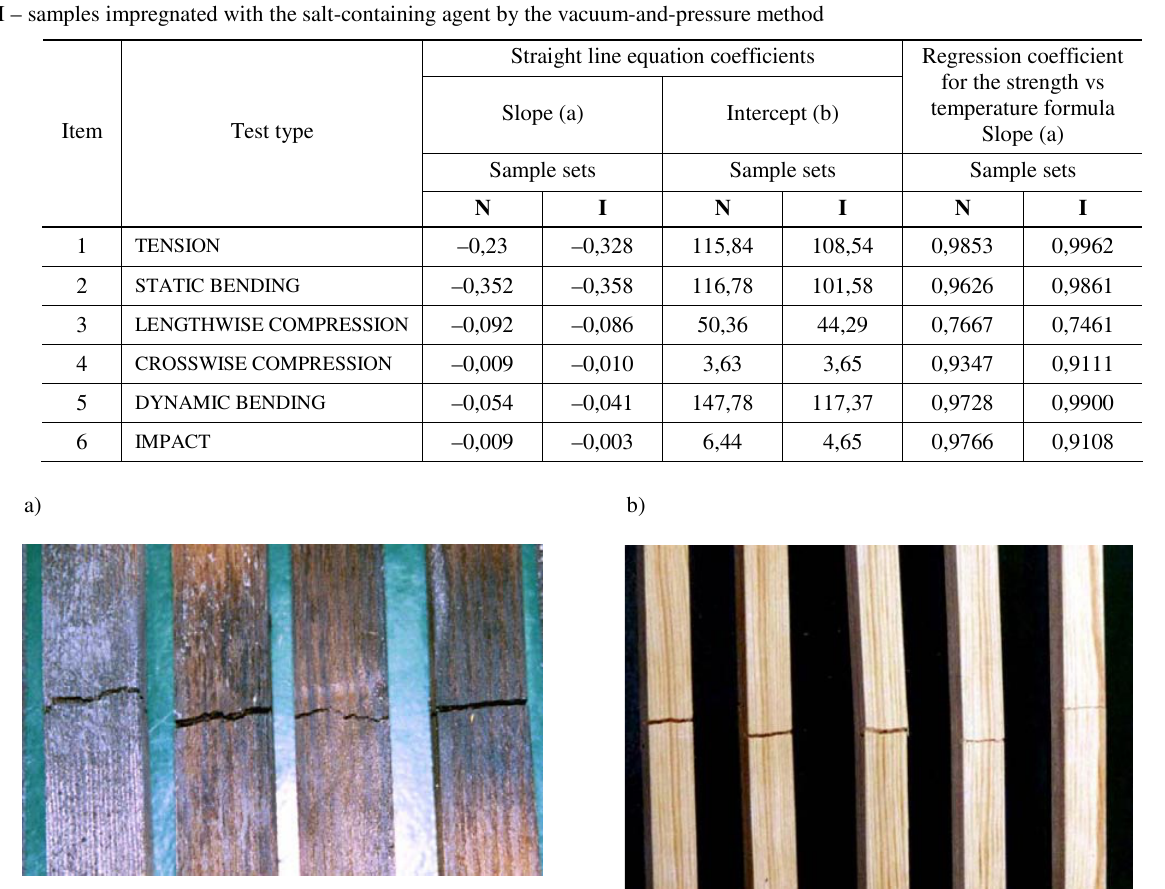
Fig 12. Smooth fractures of impregnated samples after static bending tests: a) at 230 °C; b) at 20 °C